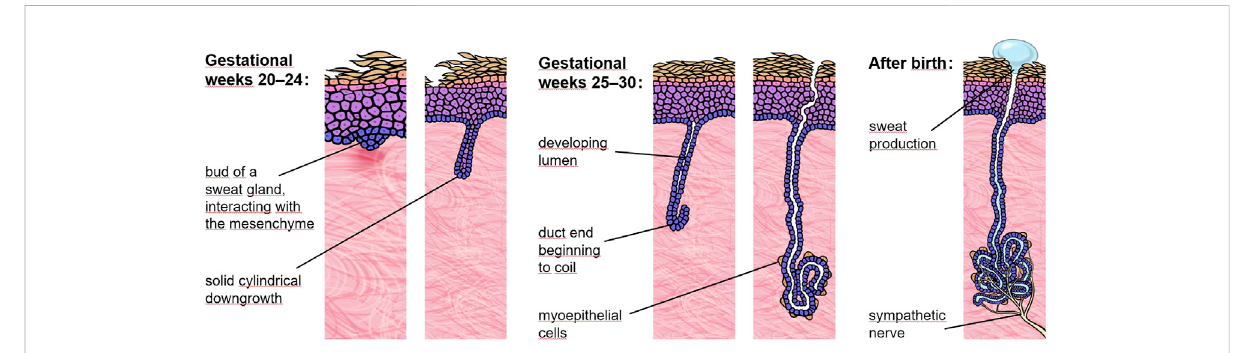
FIGURE 1 Eccrine sweat gland development. In the human fetus, eccrine sweat glands begin to form in palmoplantar skin and a bit later (around gestational week 20) across the rest of the body. At 30 weeks of gestation most sweat glands have already completed the critical portion of development but still lack sympathetic